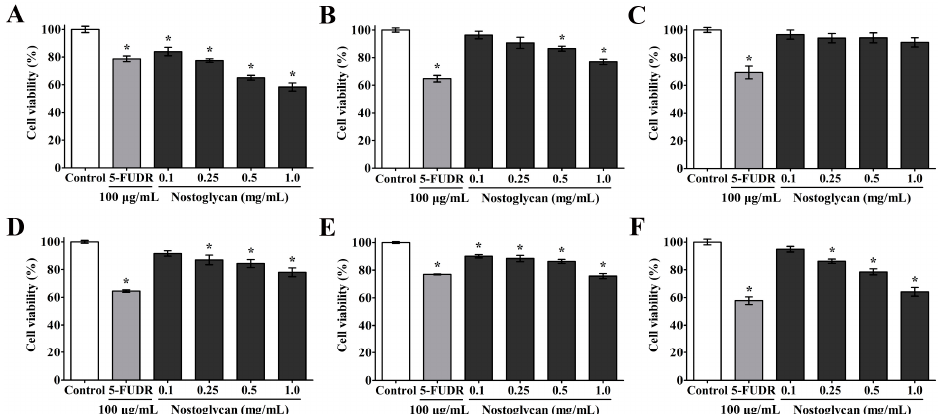
Figure 4. Effect of nostoglycan on the proliferation of tumor cells. Human tumor cell lines A549 ( A );